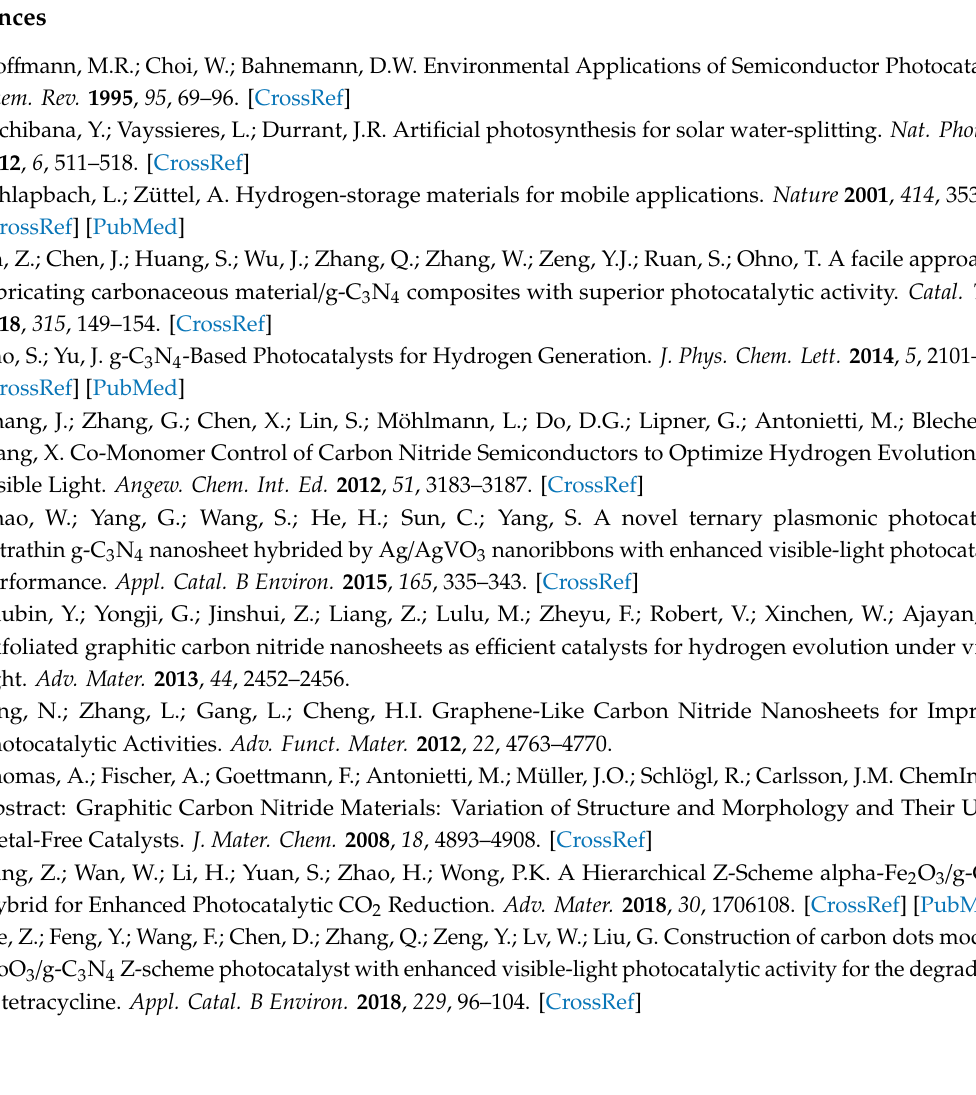
Figure S1. XRD patterns of Ti-M, Zr-M, Ce-M and Er-M. Figure S2. PL spectra for xCe-MOF. (x = 0.010, 0.015, 0.030 and 0.090). Figure S3. SEM images for ( a ) Ti-C 3 N 4 , ( b ) Zr-C 3 N 4 , ( c ) Ce-C 3 N 4 , and ( d ) Er-C 3 N 4 . Figure S4. Plots of ( α h υ ) 2 versus photon energy (h υ ) of CA-CN, HF-CN, and